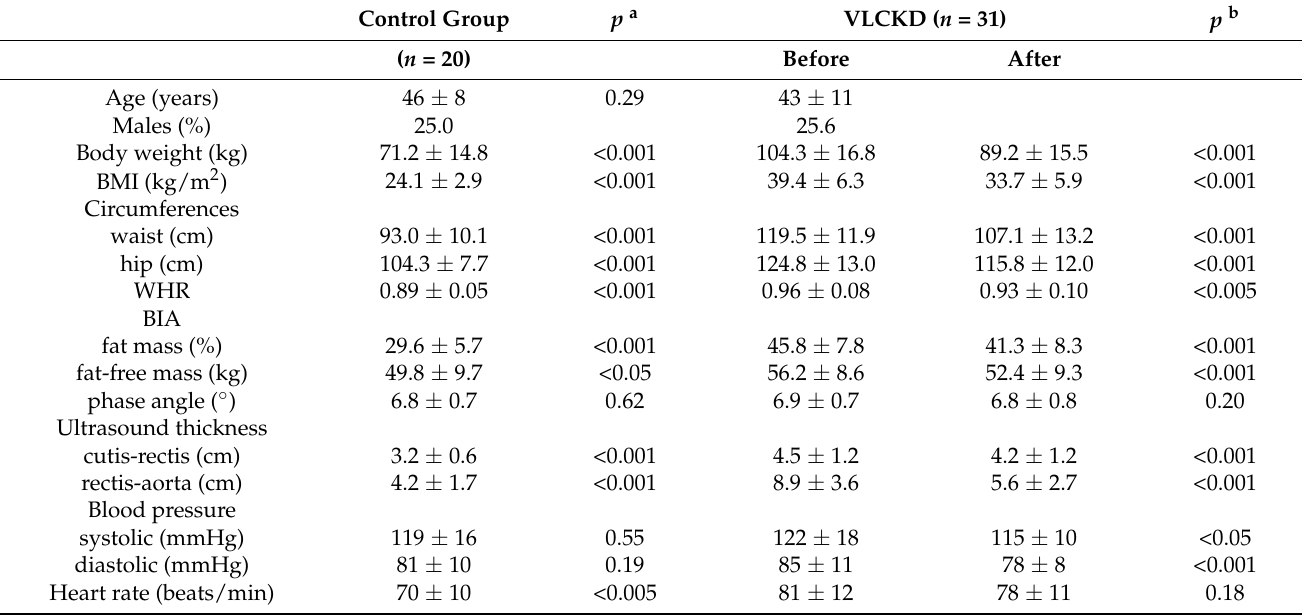
Table 1. Physical and clinical characteristics of patients with obesity before and after dietary treatment. Control